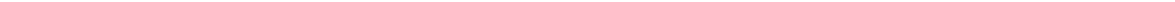
Fig. 5 WASp de fi ciency leads to impaired bacterial autophagy. a WT or WAS KO BMDCs were co-cultured with WT EPEC (MOI of 5) for 0.5 or 1.5 h. After co-culture, uninfected control and infected cell lysates were immunoblotted for LC3-I and LC3-II expression. β -Actin was used as a loading control. A representative of three experiments is shown. b WT or WAS KO BMDCs were co-cultured with WT EPEC (MOI of 5) for 3 h. Infected cells were fi xed and stained for bacteria (DAPI), F-actin (green), p62 (red) and LC3 (yellow). Co-localization of p62 and LC3 to DAPI-bacteria compartmentalized within an actin-based structure in WT (upper panel) and not in WAS-KO (lower panel) BMDCs. Images were taken at ×63 magni fi cation. Scale bar = 5 µ m. c Percentage of BMDCs showing close association between WT EPEC (MOI of 5) and LC3 puncta 3 h after co-culture. Quanti fi cation was performed on at least 500 BMDCs. Data presented are from two independent experiments done in triplicate. Data are presented as mean ± SEM. Two-sided Student ’ s t - test. d WT or WAS KO BMDCs were co-cultured with WT EPEC (MOI of 5) for 3 h, followed by gentamicin treatment for 2 h. After infection, cells were fi xed and processed for TEM, followed by image acquisition. The black boxed region of the TEM image is enlarged and shown. The scale bar represents 500 nm ( fi rst row, left and right; second row, left; third row, left and middle; fourth row, left) and 100 nm ( fi rst row, middle; second row, middle and right; third row, right; and fourth row, middle and right). e BMDCs were treated with rapamycin for 2 h, followed by EPEC infection (MOI of 5) for 3 h. Rapamycin was maintained throughout the period of infection. Culture supernatants were collected for IL-1 β quanti fi cation by ELISA. Data are presented as mean protein concentration ± SEM from three independent experiments in duplicate. Two-sided Student ’ s t -test. ** p = 0.01; *** p <